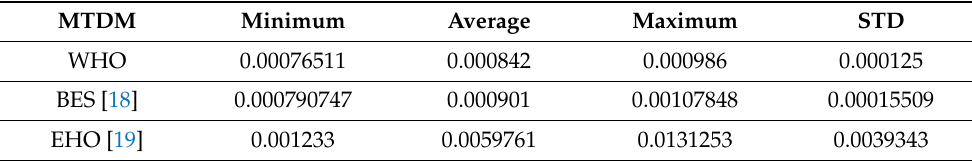
Table 3. The statistical results of MTDM for WHO and other algorithms.